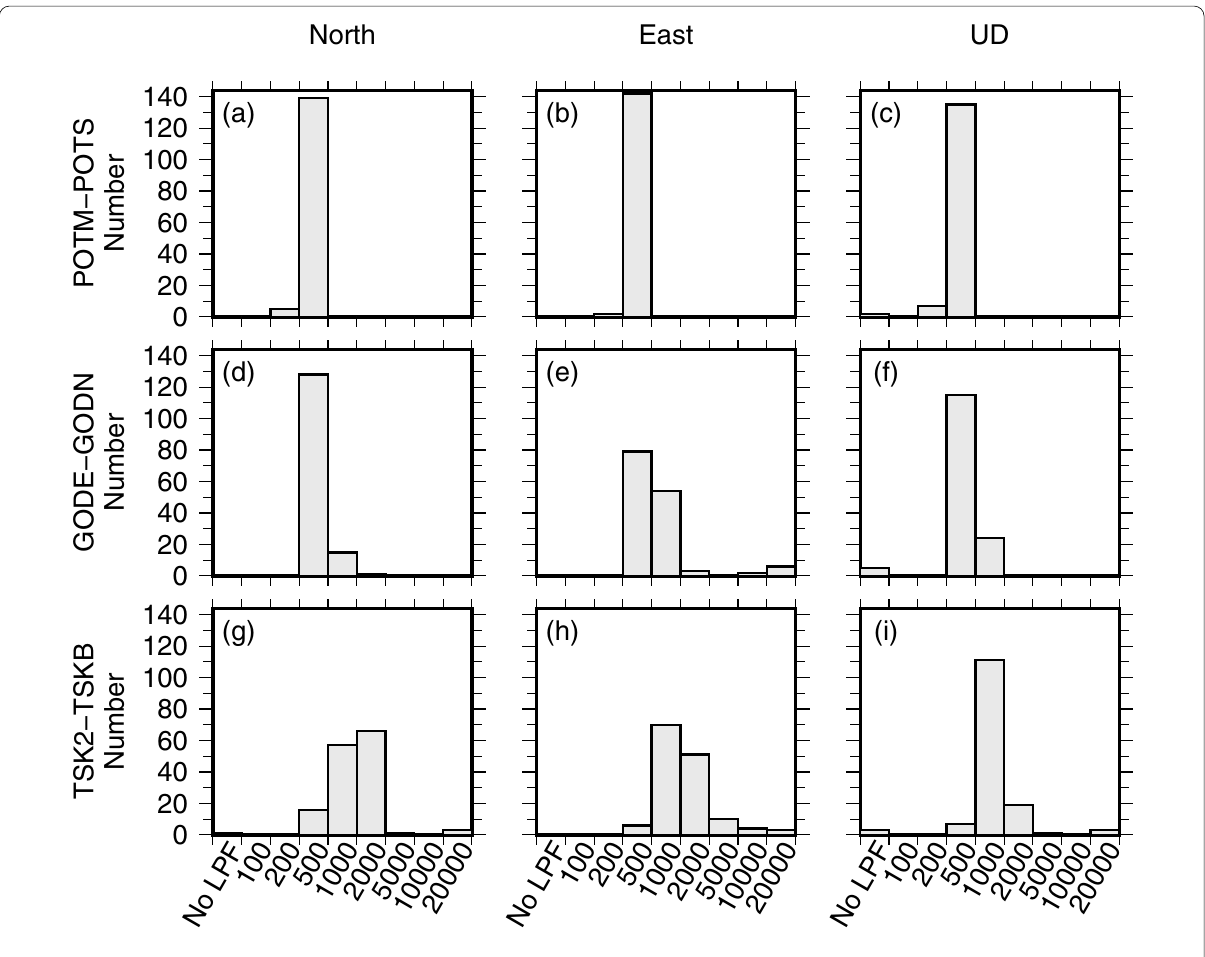
Fig. 8 Histograms of cut-off periods of low-pass filtering (LPF) which provides the maximum variance reduction for each pair of neighboring blocks. a – c North ( a ), east ( b ), and up ( c ) components of a baseline POTM-POTS. d – f Same as a–c but for GODE-GODN. g – i Same as a–c but for